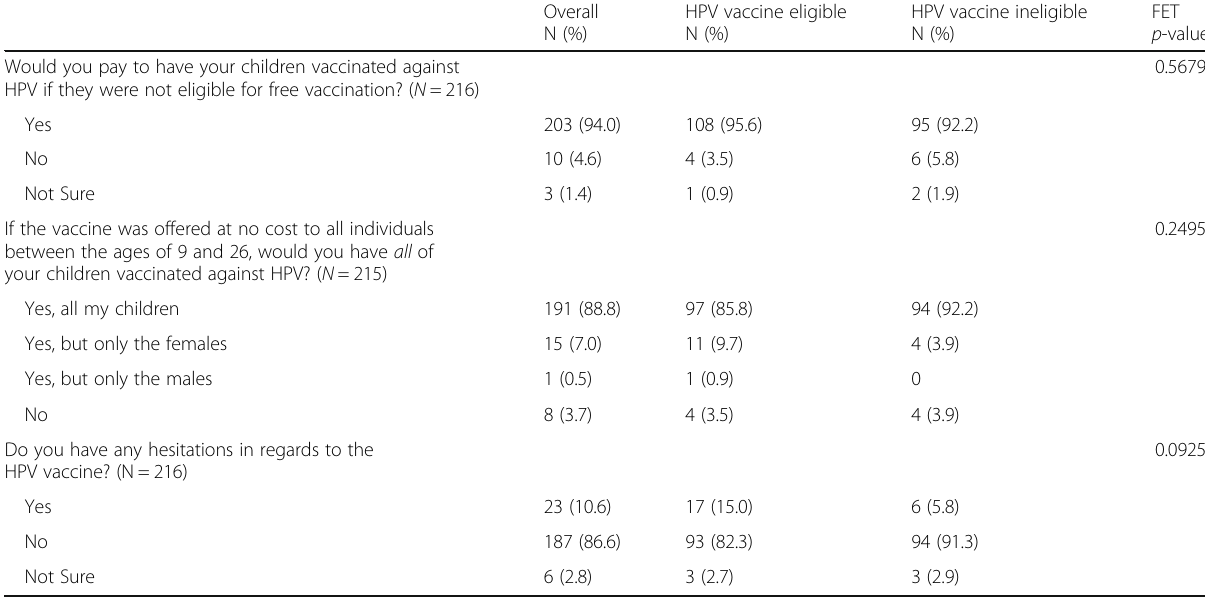
Table 2 Attitudes of parents with children between the ages of 9 and 17 regarding the HPV vaccine and its provision to currently excluded populations